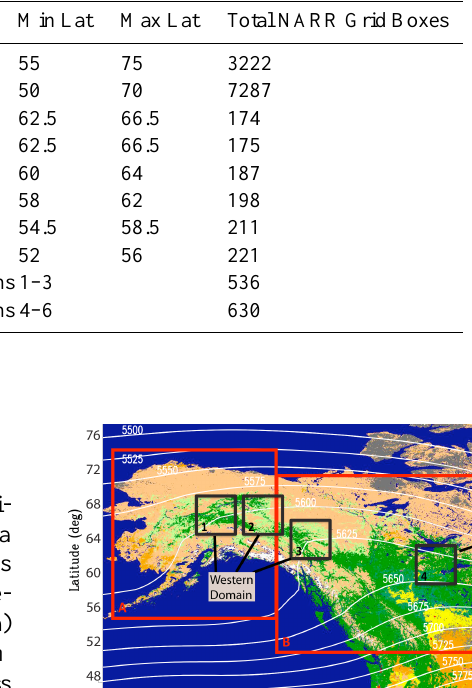
Table 1. Specifics of the study regions displayed as red or black boxes in Fig. 1.